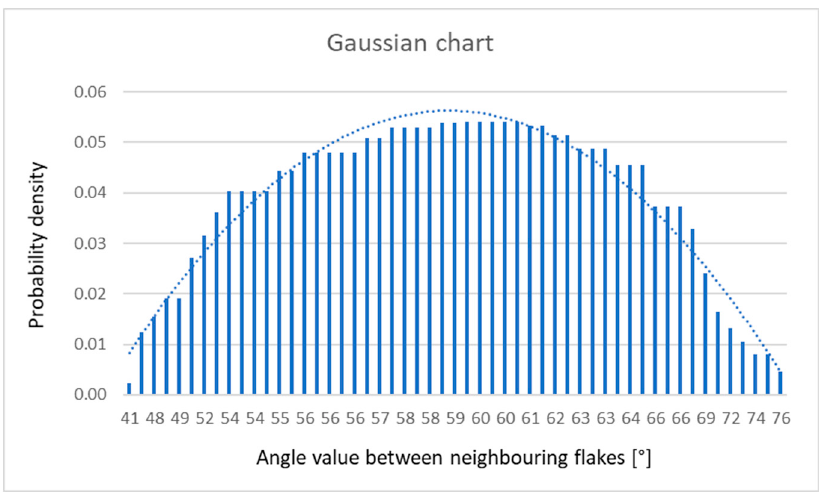
Figure 6. Gaussian chart representing the normal distribution of the angles measured between neighboring flakes.